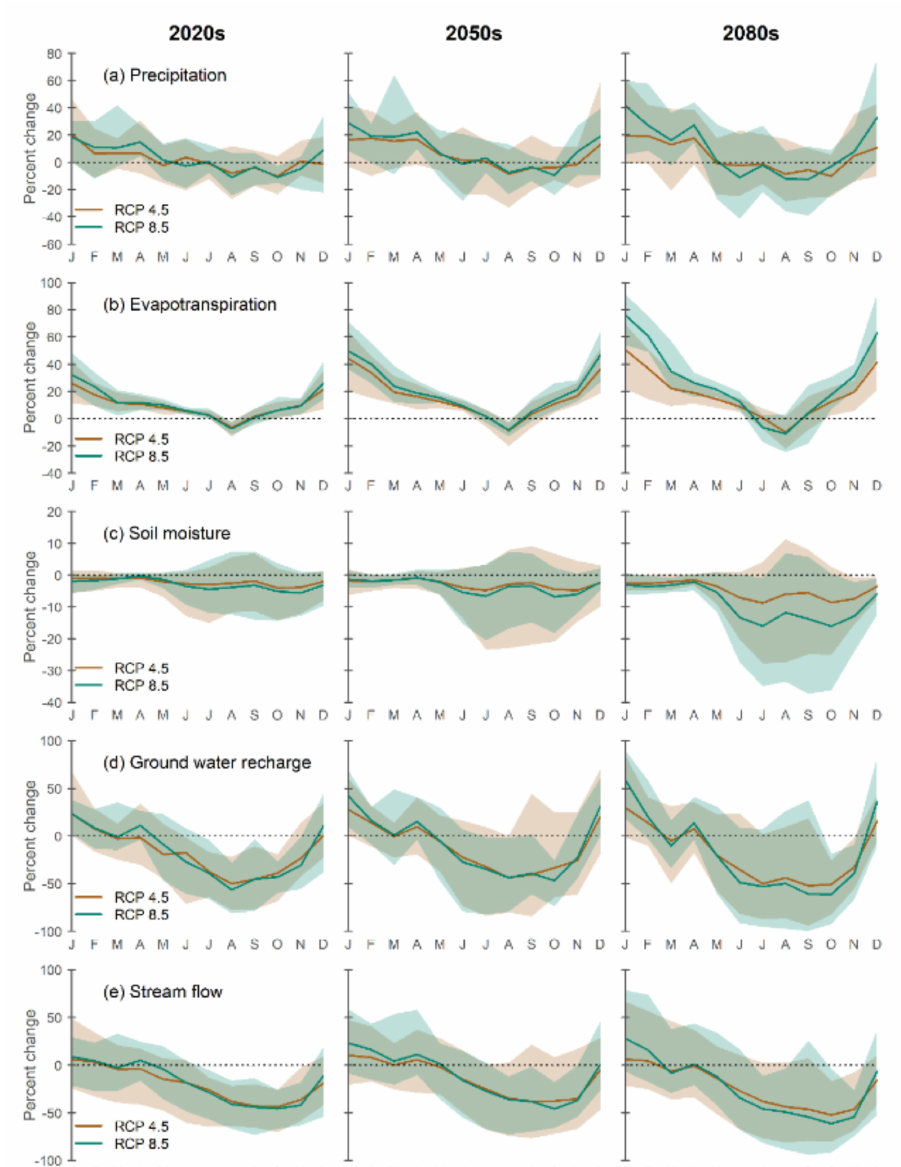
Figure 4. Projected monthly changes in major water balance components: ( a ) total precipitation, ( b ) actual evapotranspiration, ( c ) soil moisture, ( d ) ground water recharge, and ( e ) stream flow (at the basin outlet) from the 10-member GCM ensemble for representative concentration pathways (RCP) 4.5 and 8.5. Semi-transparent shading represents ensemble spread; solid lines show ensemble mean; dotted line highlights the historical baseline (1971–2000). For the three future periods: 2020s = 2011–2040; 2050s = 2041–2070; and 2080s =